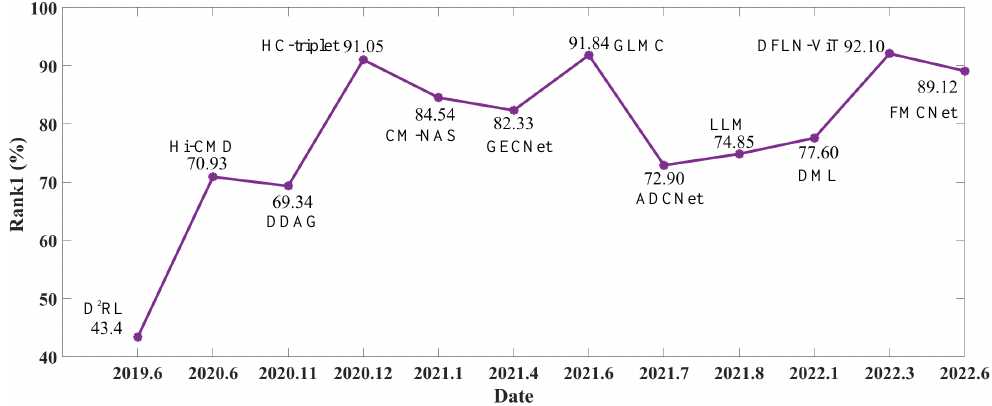
Figure 2. The Rank-1 (i.e., rank-1 accuracy) comparison of state-of-the-art